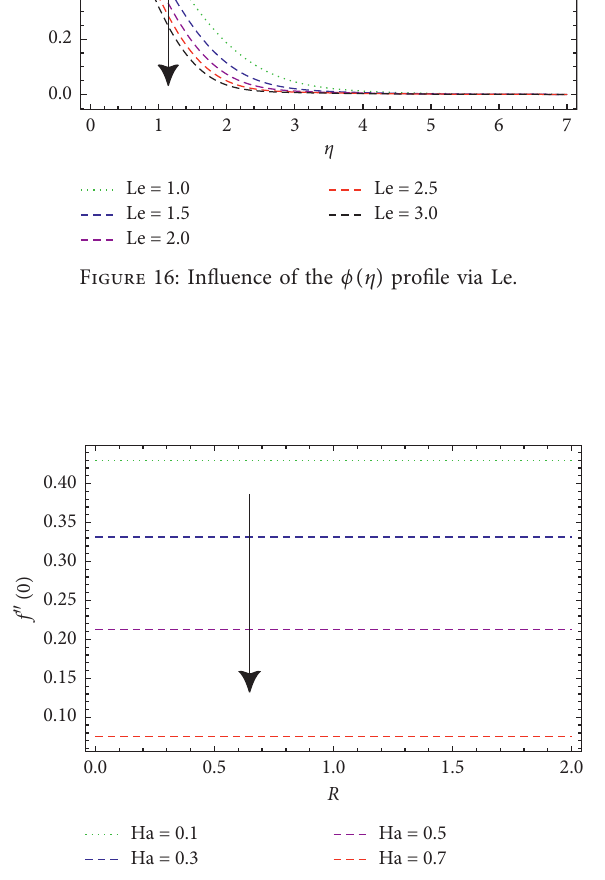
Figure 17: Skin friction/drag force via R for different values of Ha.